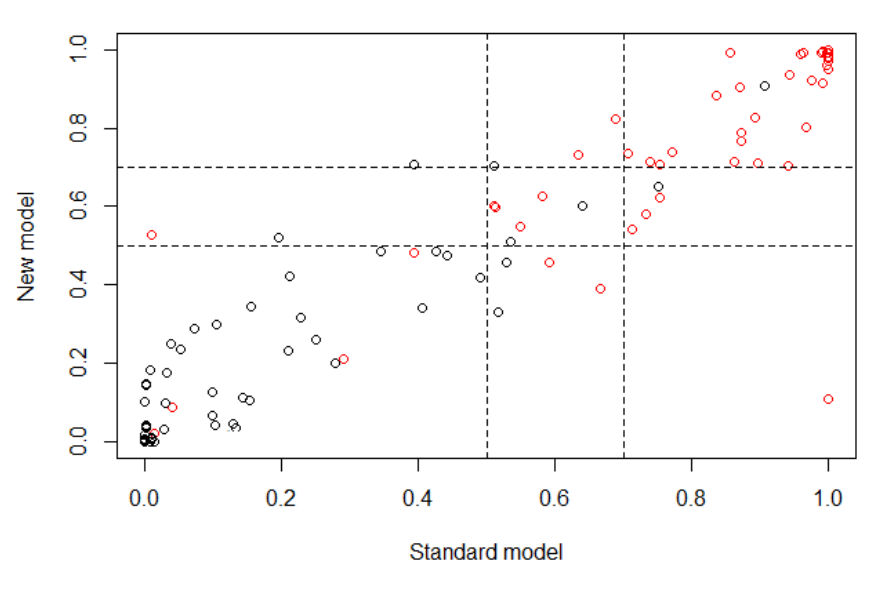
Figure 3. Plot of the risk category based on the NRI calculus for age group 2; horizontal axis represents the standard model or the multivariate model before the feature selection and vertical axis represents the new model or the multivariate model after the feature selection (control ◦ , case ◦ ).